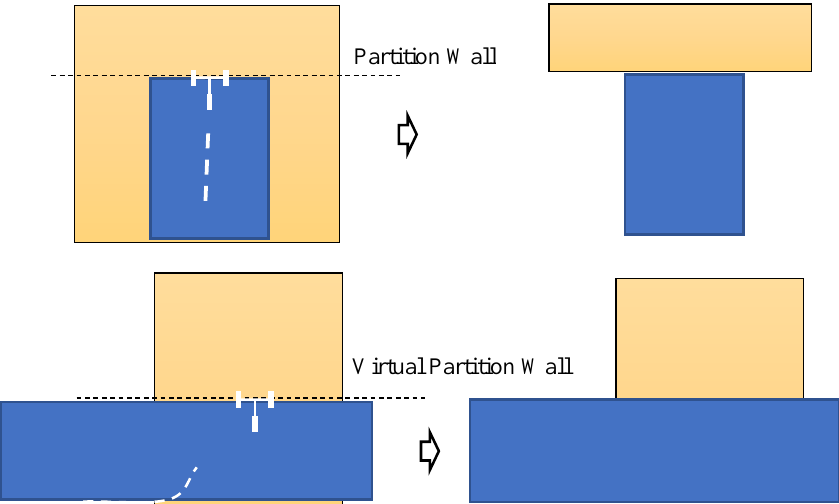
Figure 10. Determination of partitioned wall between rooms.